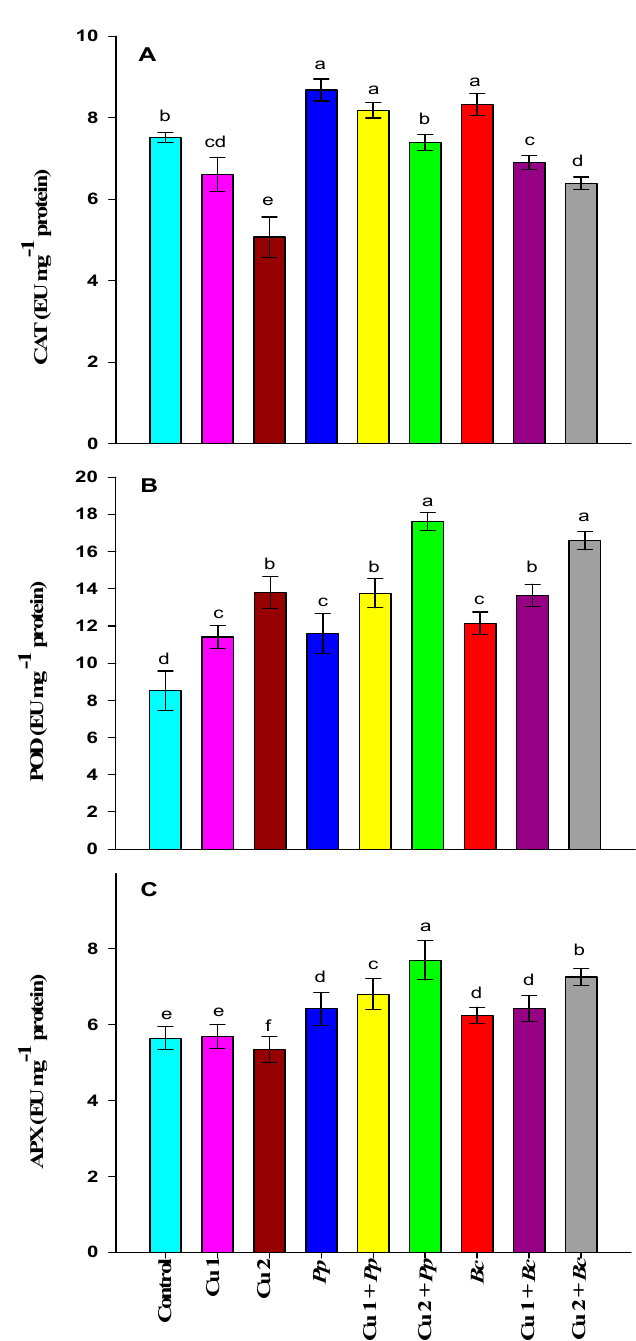
Figure 2. Effects of bacterial inoculation under copper stress on the activities ( A ) catalase (CAT), ( B ) peroxidase (POD), and ( C ) ascorbate peroxidase (APX) in leaves of maize plants. Bars represent the standard deviation (± SD) of the means ( n = 3). Different letters indicate significant differences among the treatments at p ˂ 0.05, according to Duncan’s multiple range test. The treatments include Control, plants without copper stress and bacterial strains inoculation; Cu 1: plants exposed to 100 µM CuSO 4 ; Cu 2: plants exposed to 500 µM CuSO 4 ; P. polymyxa ( Pp ) inoculated plants without CuSO 4 ; Cu 1 + Pp : plants exposed to 100 µM CuSO 4 and inoculated with P. polymyxa ; Cu 2 + Pp : plants exposed to 500 µM CuSO 4 and inoculated with P. polymyxa ; B. circulans ( Bc ) inoculated plants without CuSO 4 ; Cu 1 + Bc : plants exposed to 100 µM CuSO 4 and inoculated with B. circulans and Cu 2 + Bc : plants exposed to 500 µM CuSO 4 and inoculated with B. circulans .